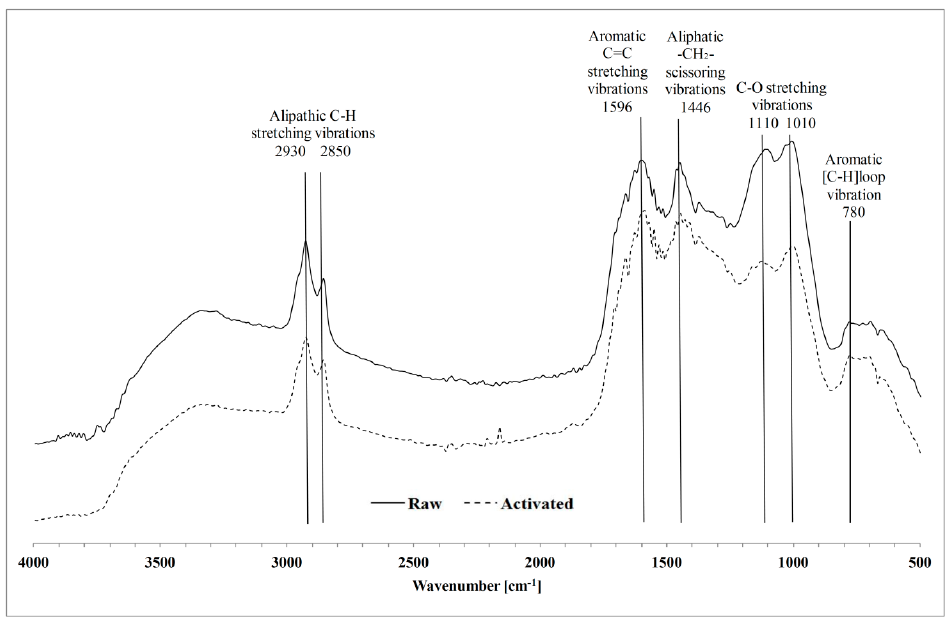
Figure 2. FTIR-PAS spectra of raw and activated hydrochar.